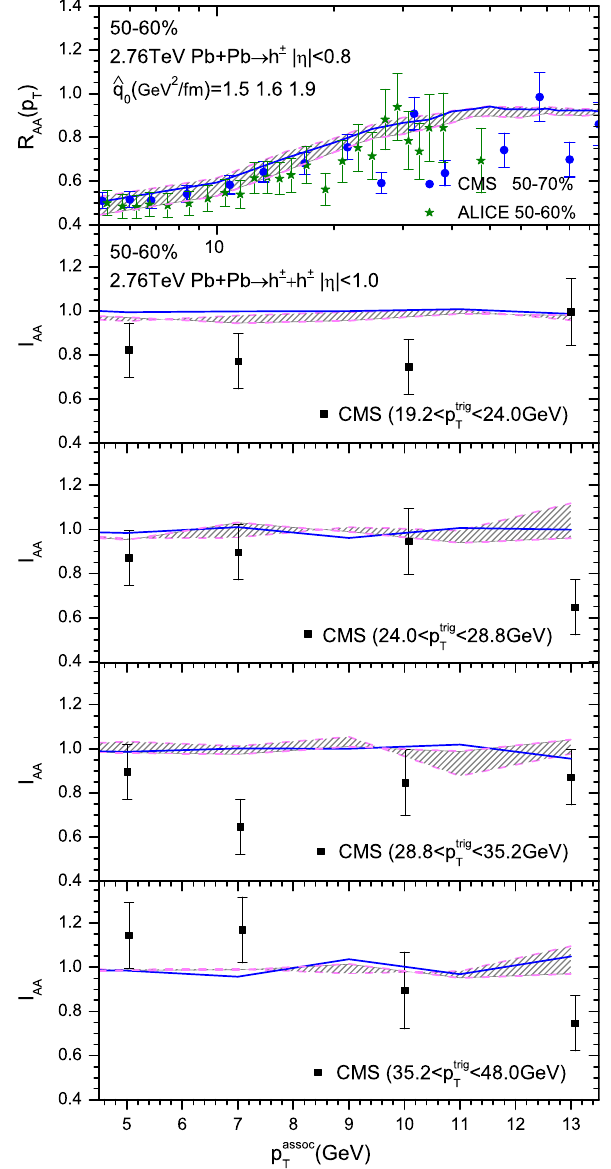
tor I AA in central Pb+Pb collisions at (left) and central Xe+Xe collisions at (right). Different panels are the results with different trans- Fig. 6 The single hadron and dihadron suppression factors in non- √ verse momenta for trigger hadrons. In each plot, the solid s NN = 2 . 76 TeV compared central (50–60%) Pb+Pb collisions at with ALICE [37] and CMS [38,45] data lines in the middle are the results using the best ˆ q 0 values, while the other two lines represent the theoretical which we take ± 0 . 1 GeV 2 /fm around the best ˆ q 0 values fitted